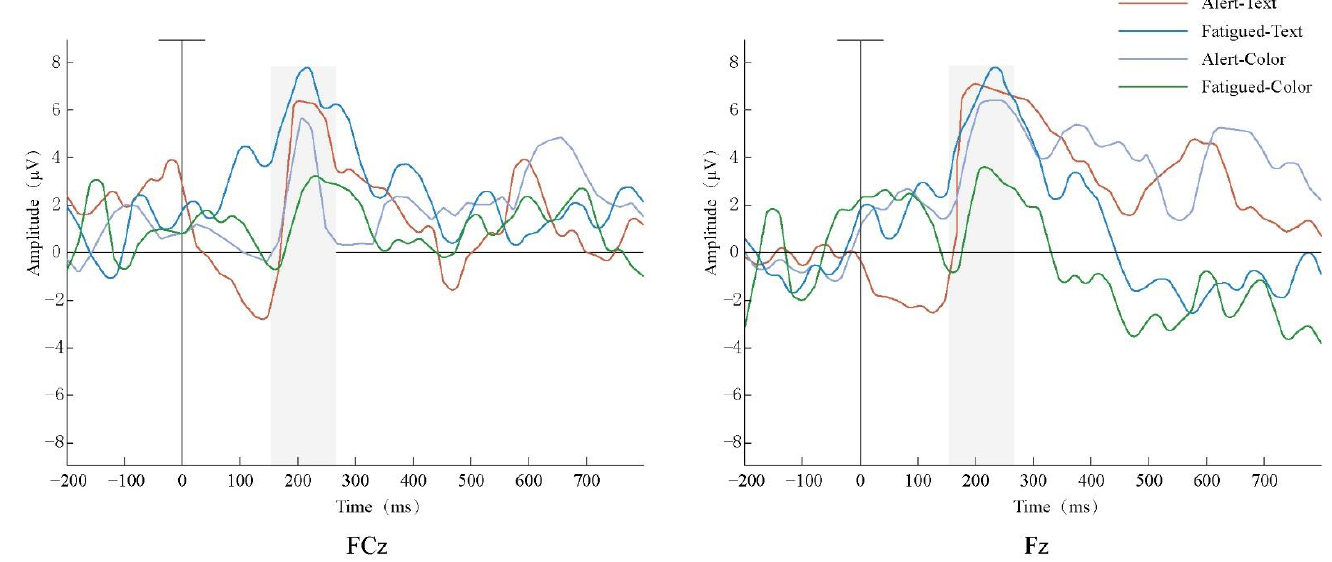
Figure 8. Target stimulation mean ERP in Fz and FCz. Table 6. Multivariate ANOVA results for P200 mean amplitude of mental state and visual code.